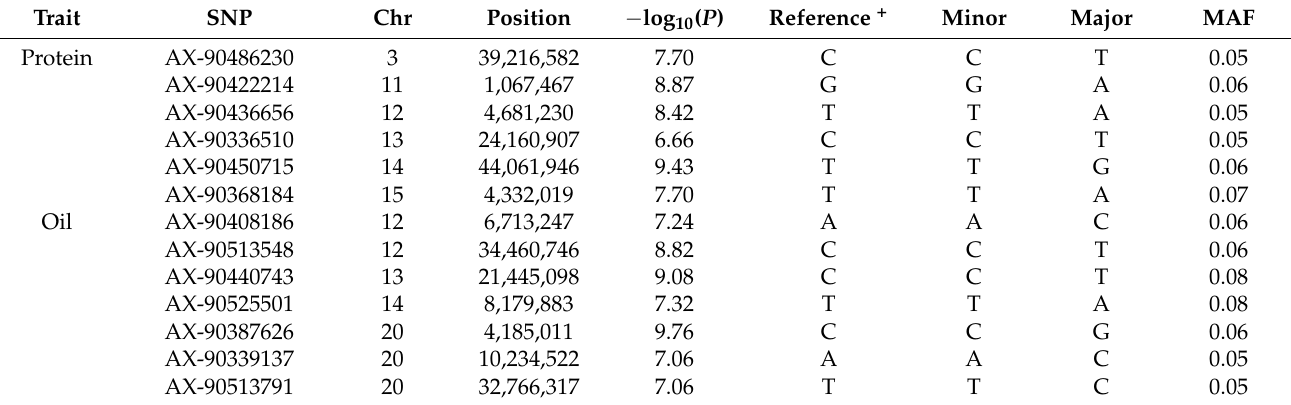
Figure 4. Manhattan plots and quantile–quantile (QQ) plots for protein and oil content in 203 wild soybean accessions. In the Manhattan plots, the blue line indicates the genome-wide threshold -log 10 ( P ) = 4.98 and the red line represents -log 10 ( P ) = 6.29, calculated using the Bonferroni method. The allelic e ff ect of the SNP marker was estimated for each trait, and the highest dif- Table 3. Significant SNP markers related to protein and oil content in the merged phenotype. ferences per trait are displayed in Figure 5. The protein-associated SNP marker AX- 90422214 on chromosome 11 had the alleles G/A, and the average protein content for in- dividuals with GG alleles was 42.84 g, which was 5.35 g lower than the average protein content for individuals with AA alleles (48.19 g). In addition, the oil-associated SNP marker AX-90513548 on chromosome 12 had the alleles C/T, and the average oil content